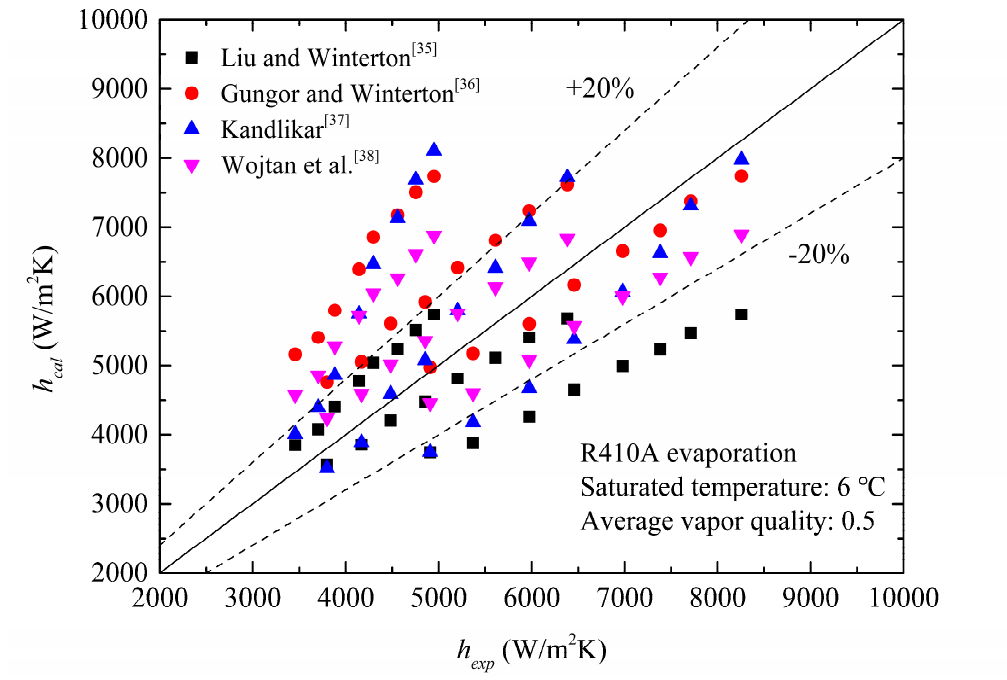
Figure 9. Evaluation of four heat transfer correlations for evaporation heat transfer in the